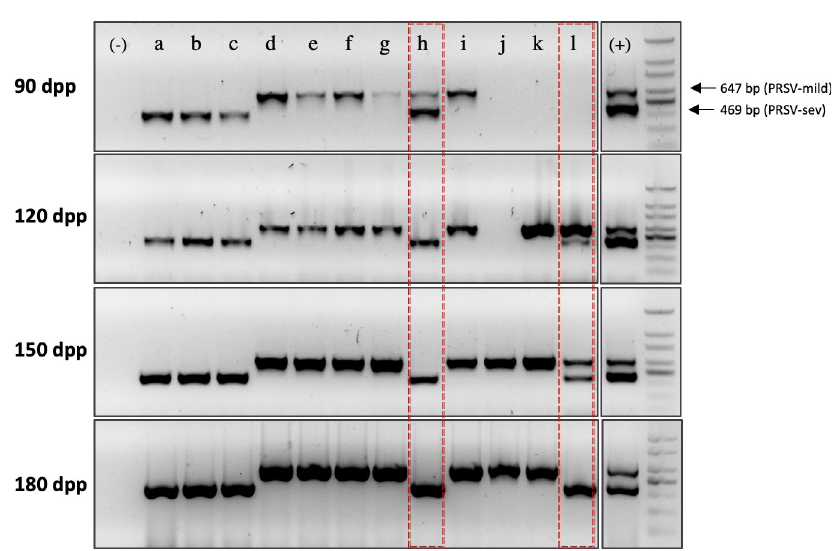
Fig 4. Dynamics of the papaya ringspot virus mild (PRSV-mild) and severe (PRSV-sev) isolates under field conditions. Progressive testing of PRSV-mild and PRSV-sev by reverse-transcription PCR. Different testing time points are indicated (dpp: Days post planting). Arrows next to the DNA ladder indicate the amplification size (base pairs, bp) for each isolate. A set of 12 sentinel plants (represented by letters a through l) were exposed to virus infection. Dashed red boxes denote plants where co-infection of both strains was observed, which then turned into PRSV-sev single infections.